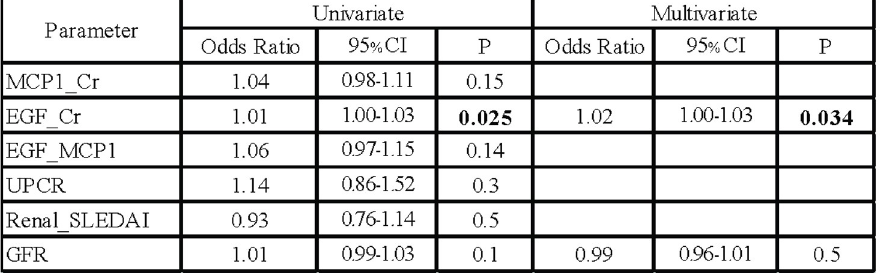
Fig 4. Urine cytokines as predictors for response to induction therapy at 6 months in proliferative nephritis (n = 41). A) Receiver operating curve to predict response. AUC (95% confidence interval); B) Univariate and multivariate analysis of factors to predict